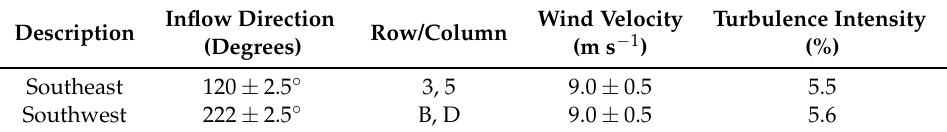
Table 3. Main inflow directions and